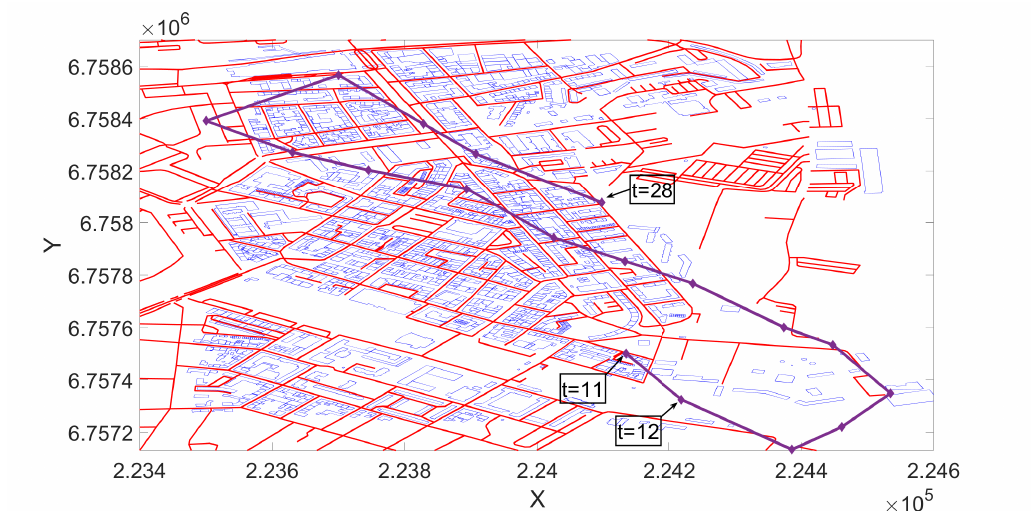
Figure 4: Sample trajectory of a participant